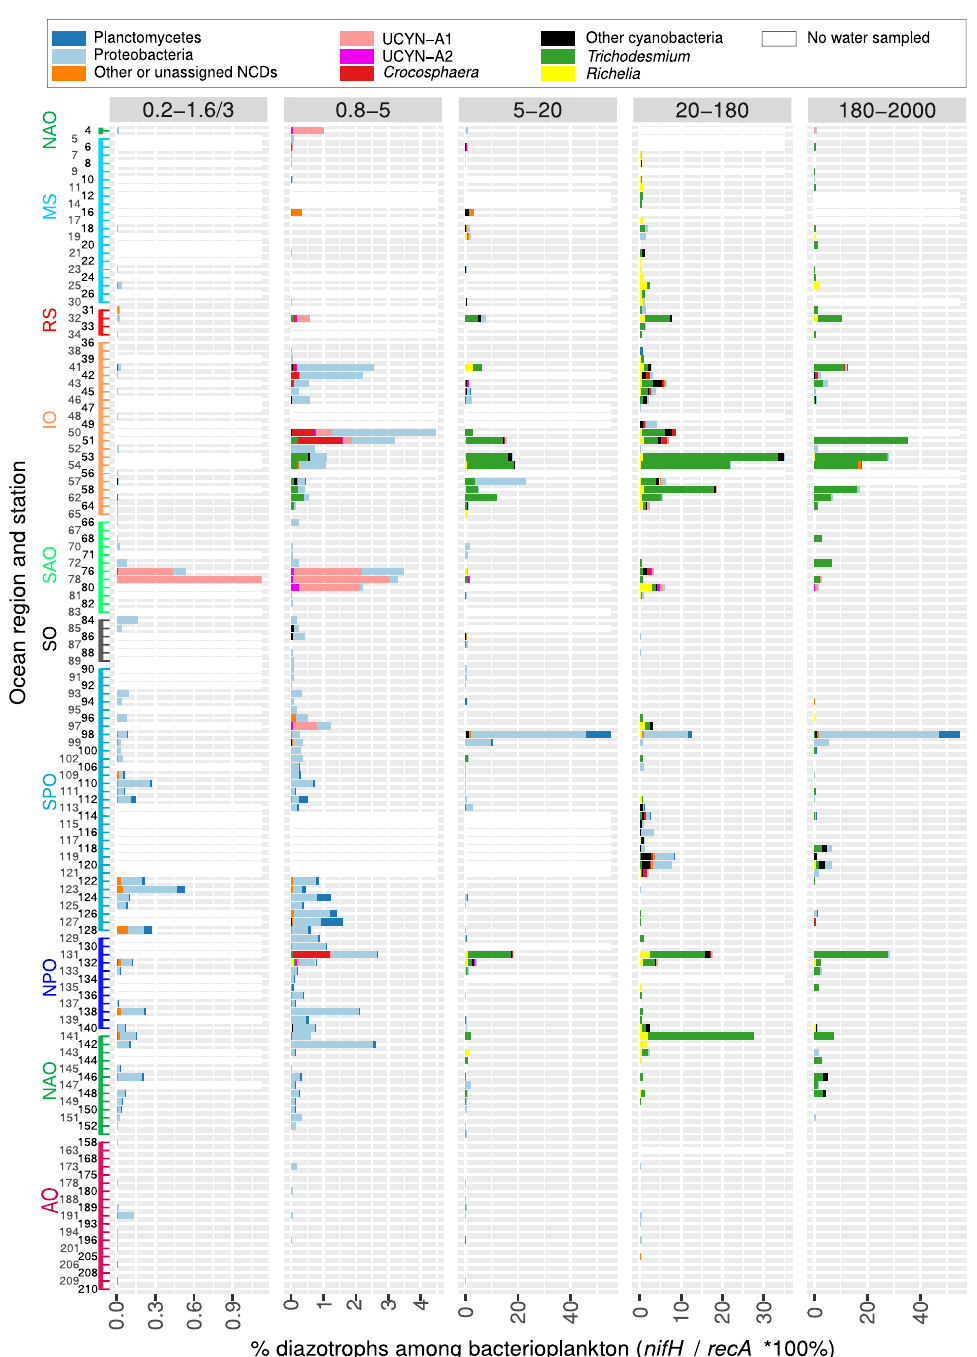
Fig. 9 Diazotroph community based on metagenomes from size-fractionated surface samples. The percentage of diazotrophs in the bacterioplankton community was estimated by the ratio of metagenomic read abundance between the marker genes nifH and recA . The bar color code shows the taxonomic annotation, while the absence of water sample is indicated by a white bar. The Y-axis shows the Tara Oceans stations and the ocean regions. MS Mediterranean Sea, IO Indian Ocean, SAO South Atlantic Ocean, SO Southern Ocean, SPO South Paci fi c Ocean, NPO North Paci fi c Ocean, NAO North Atlantic Ocean, AO Arctic Ocean. The equivalent fi gure showing the DCM water layer is shown in Fig. S2 (note the differences in scales between both fi gures, showing the higher relative abundance of diazotrophs in the surface layer). Source data are provided as a Source data fi